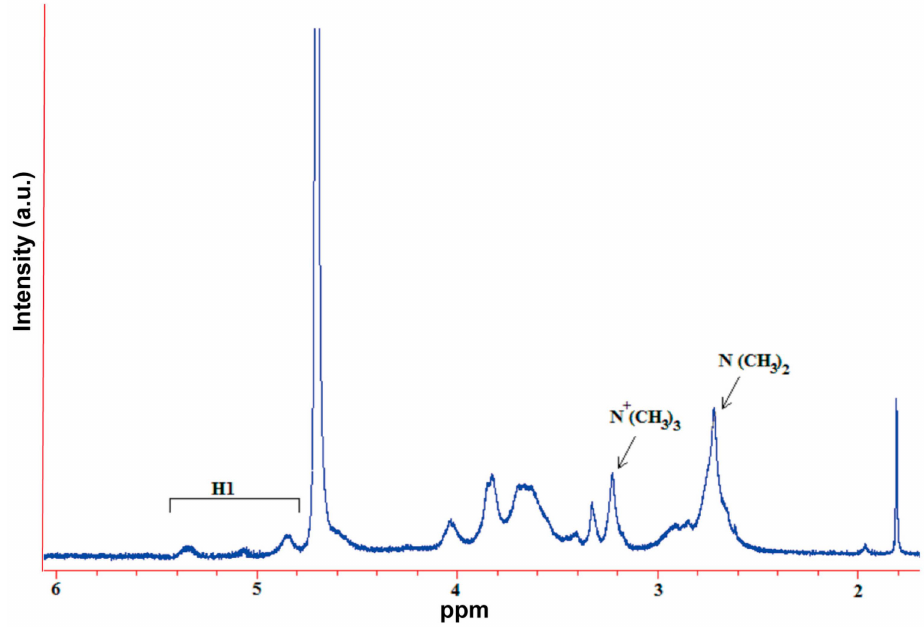
Figure 3. Characteristic 1 H-NMR spectrum of N -trimethyl chitosan (TMC) in D The average degree of quaternization (DQ) of TMC was obtained using Equation (4), which compares the area of the peak corresponding with the methyl hydrogens of the trimethylated amino group (ATM) with the area of the peak corresponding to the hydrogen atoms bonded to carbon 1 (AH1). Thus, the DQ of TMC in this study was calculated as approximately